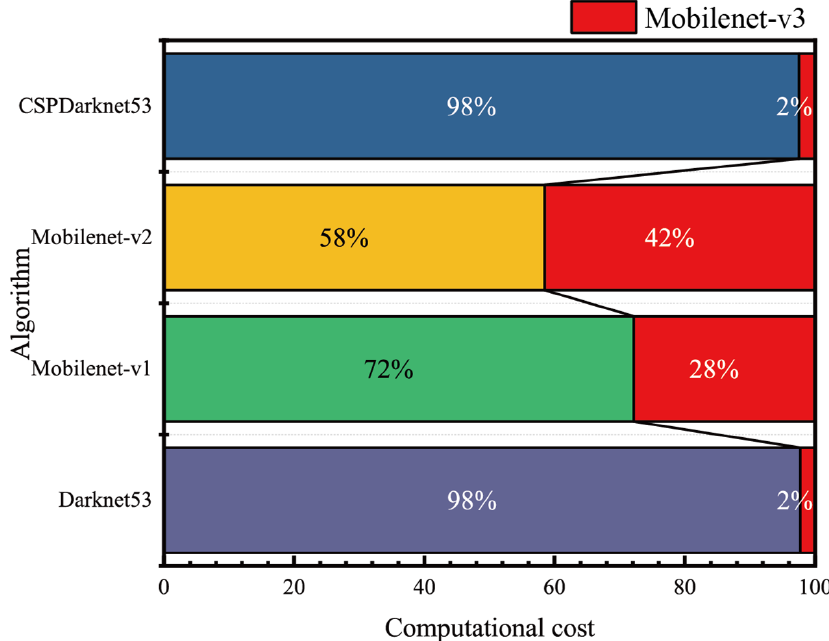
Figure 16. Comparison of the computational cost.